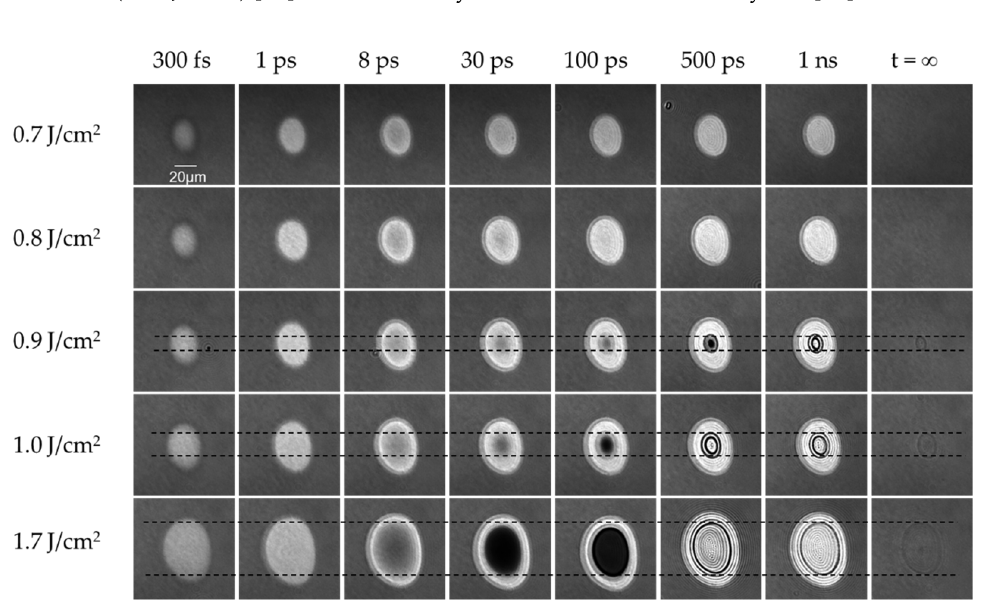
Figure 2. Time-resolved dynamic images captured at different relative pump-probe delays after excitation with a single pulse at different peak fluences. The black dashed horizontal lines indicate the white ring between two black rings (shown at a time delay of 1 ns) due to the permanent change on Si surface.